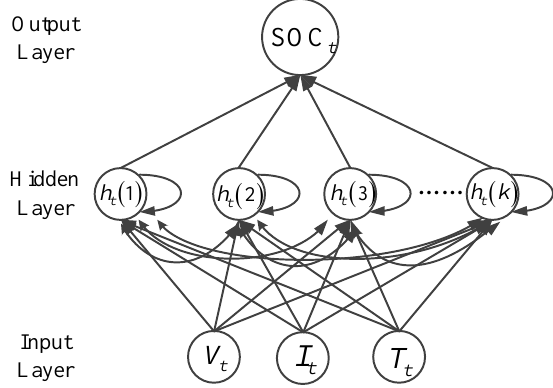
Figure 2. Architecture of the gated recurrent unit recurrent neural network (GRU-RNN) for state of charge (SOC) estimation.